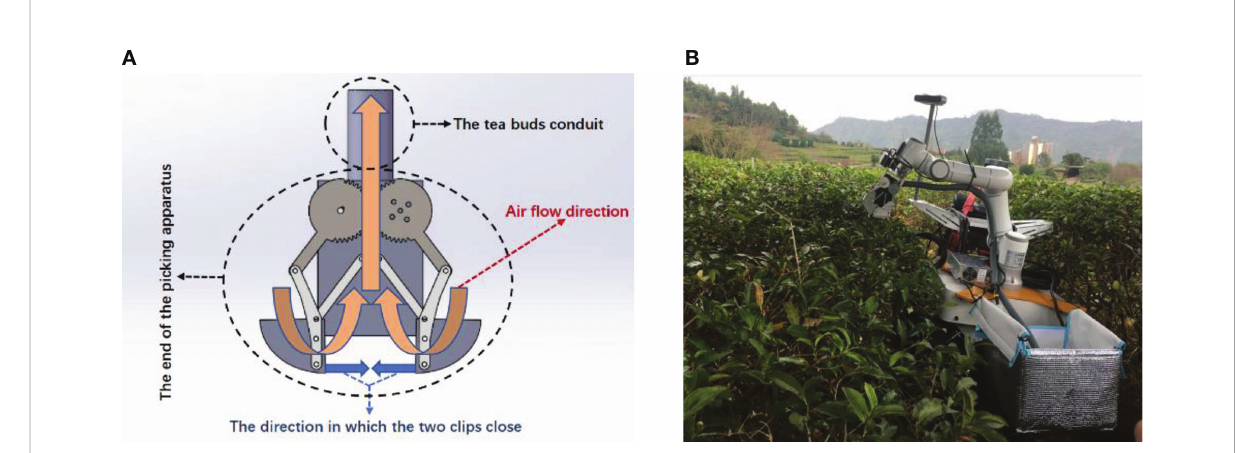
FIGURE 1 The picking robot and the end of the bud picker. (A) Structural diagram of the end of the bud picker. (B) The picking robot in the fi